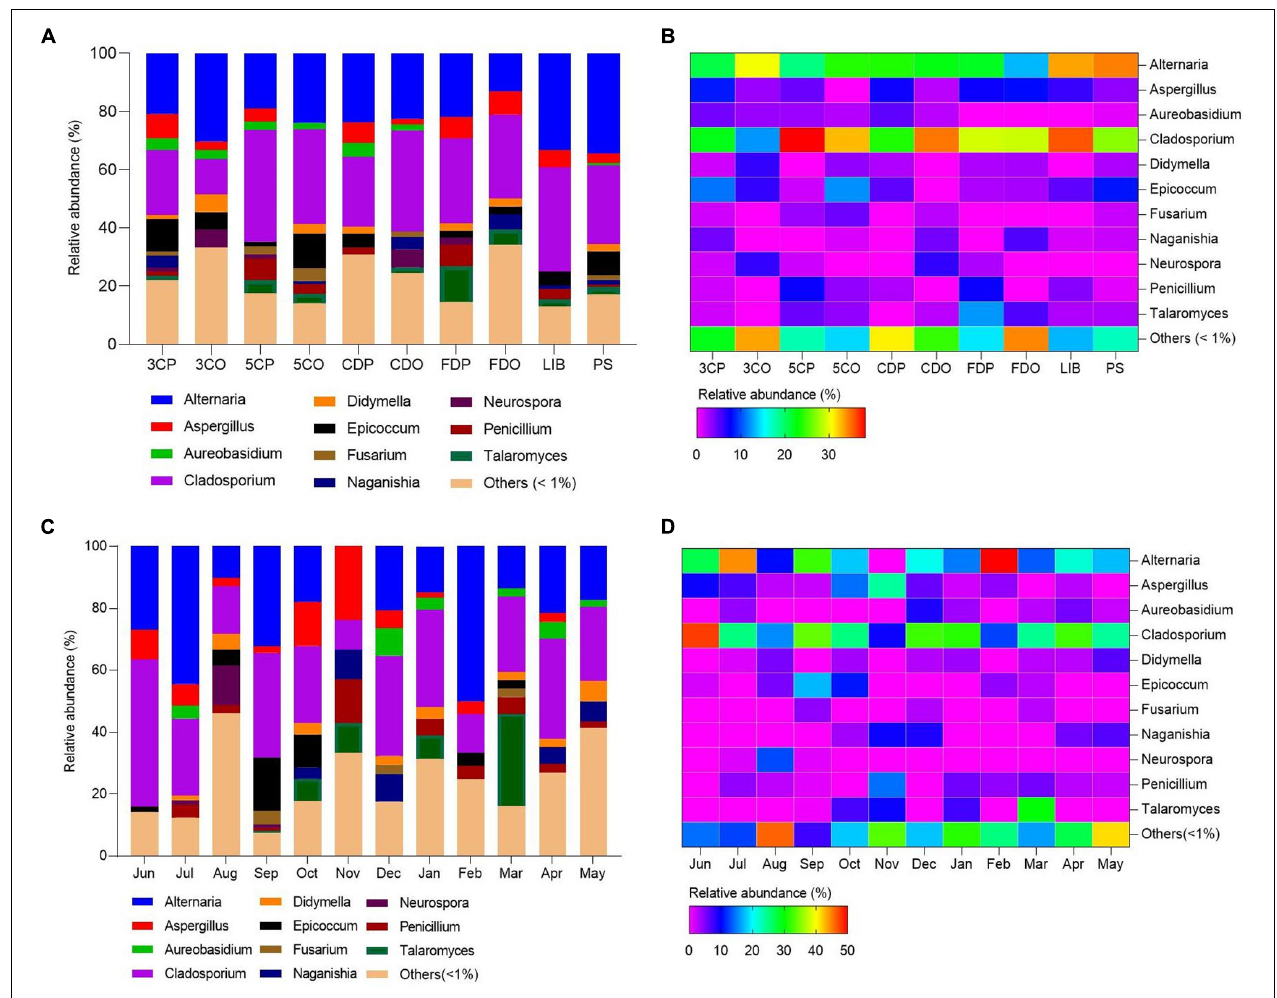
FIGURE 7 | Fungal community structures (genera) with relative abundances in the sampling locations and months. (A,C) Represent the relative abundances of fungal genera in different locations and months. (B,D) Represent the heatmaps of fungal genera.